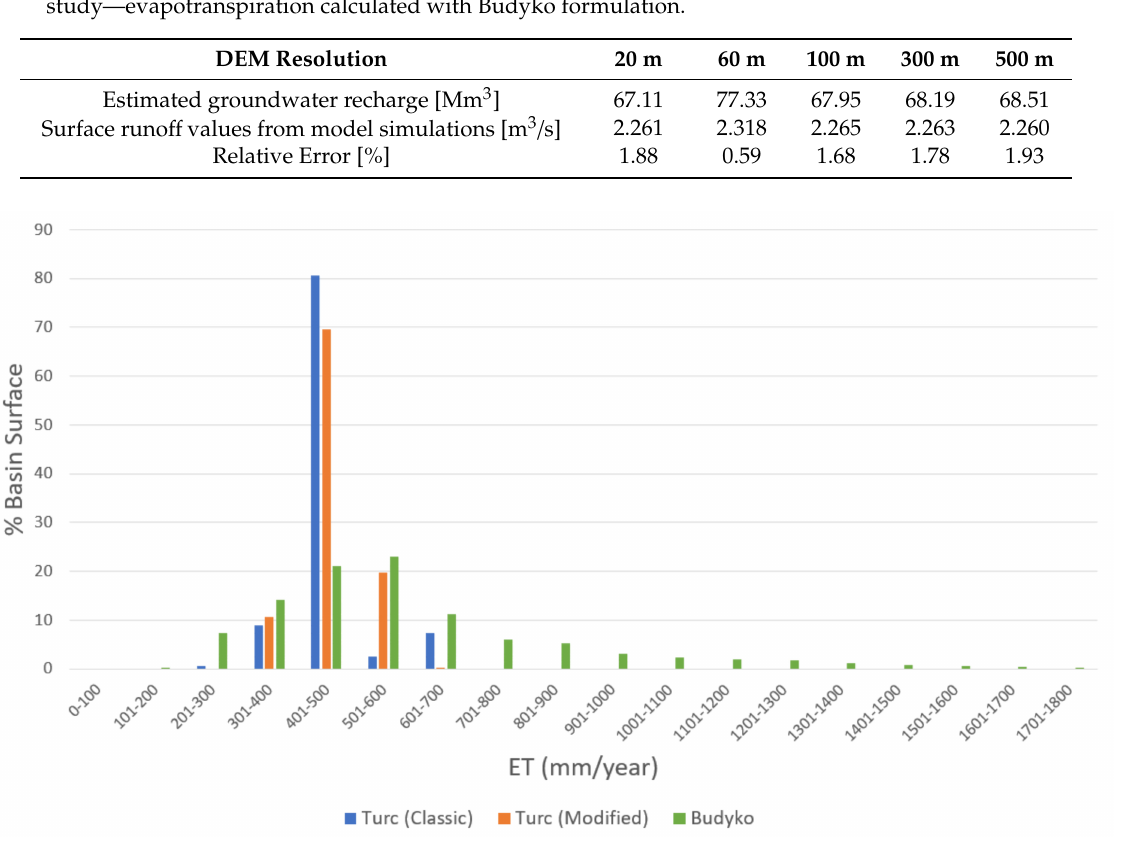
Figure 8. Spatial distribution of evapotranspiration values ET distribution over the basin according to the Turc formula (in blue), the modified Turc formula (in orange), and the Budyko equation (in